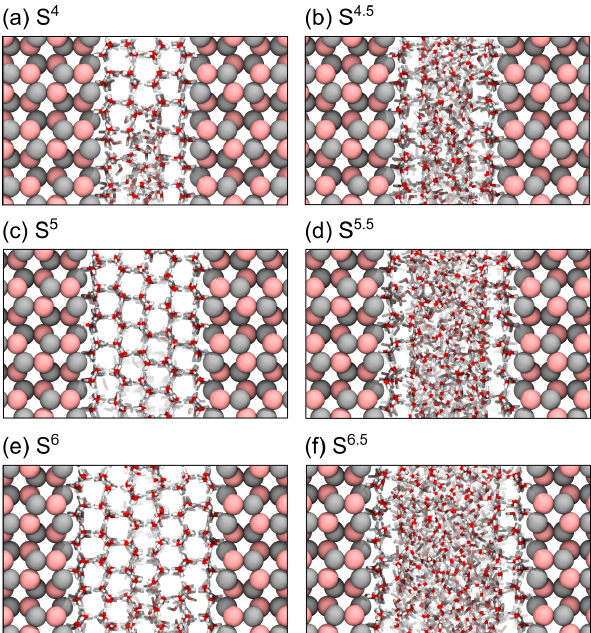
Figure 4. Snapshot details of the last frame of TIP4P/Ice simula- tions of AgI slit systems with gap widths of (a) 4 ice bilayers, (b) 4.5 ice bilayers, (c) 5 ice bilayers, (d) 5.5 ice bilayers, (e) 6 ice bi- layers and (f) 6.5 ice bilayers. Ag and I are shown in silver and pink, respectively, and water molecules are shown as red and white sticks.